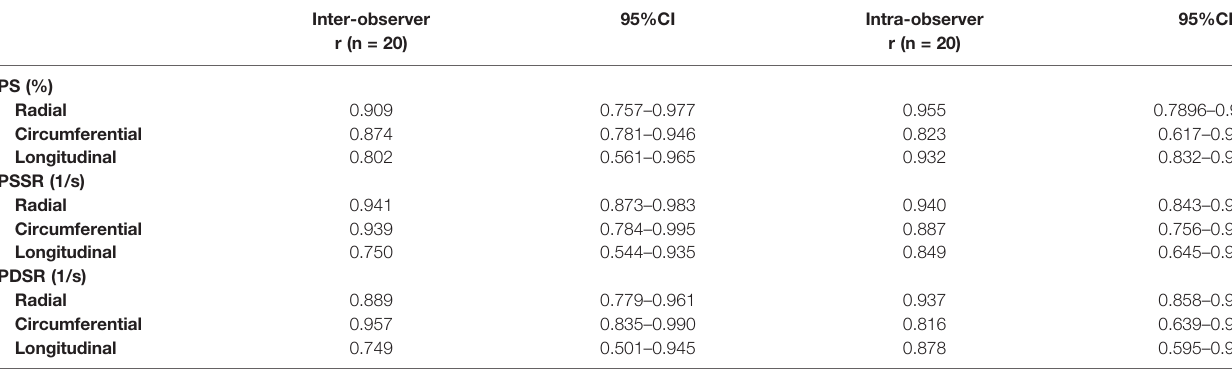
TABLE 5 | Inter-and intra-observer variability of tissue